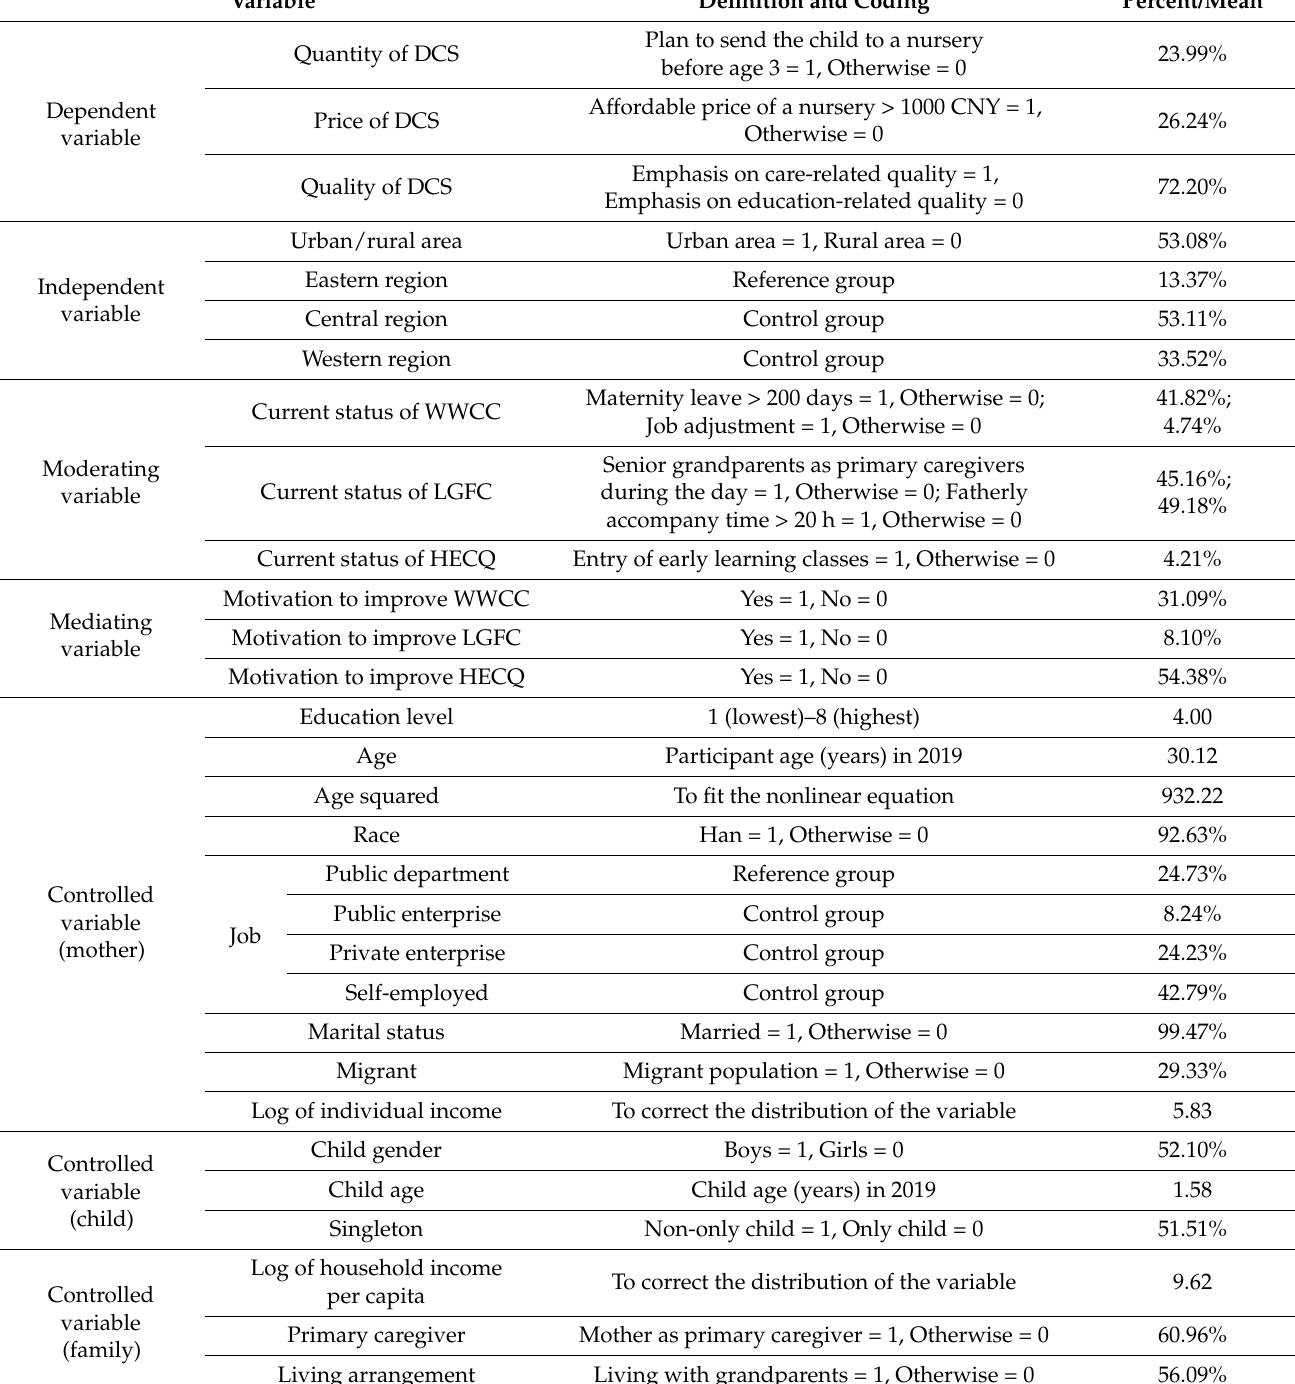
Table 1. The main variable measures and descriptive statistics (N =